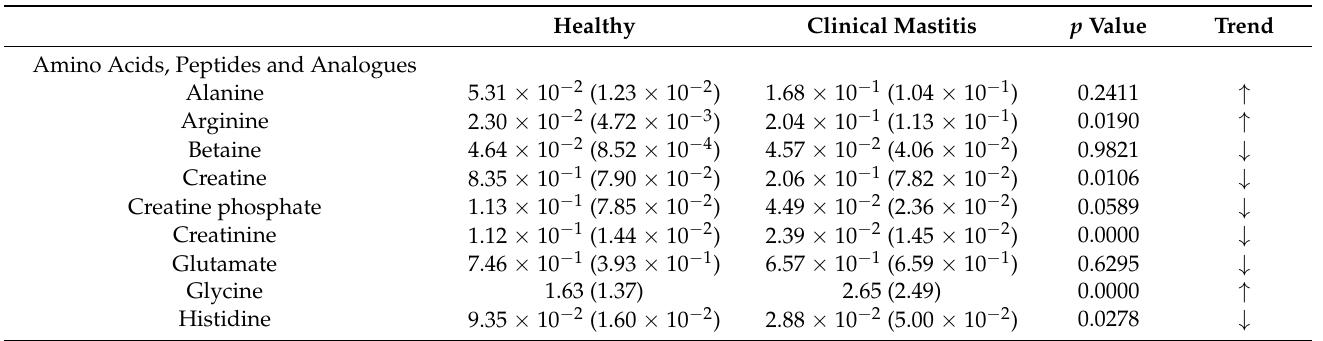
Table 1. Concentrations (mmol/L, median (IQR)) of molecules affected by clinical mastitis in milk samples. Healthy Clinical Mastitis p Value Trend Amino Acids, Peptides and